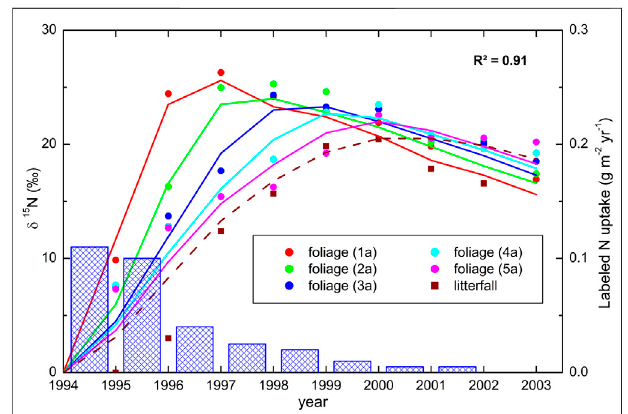
FIGURE 3 | 15 N abundances in Norway spruce needle cohorts and in litterfall in an N addition experiment in which a 15 NH 415 NO 3 tracer was applied during the initial year (Schleppi et al., 1999). Dots represent measurements and lines are modeled δ 15 N values. The modeled tracer uptake by the trees is shown as